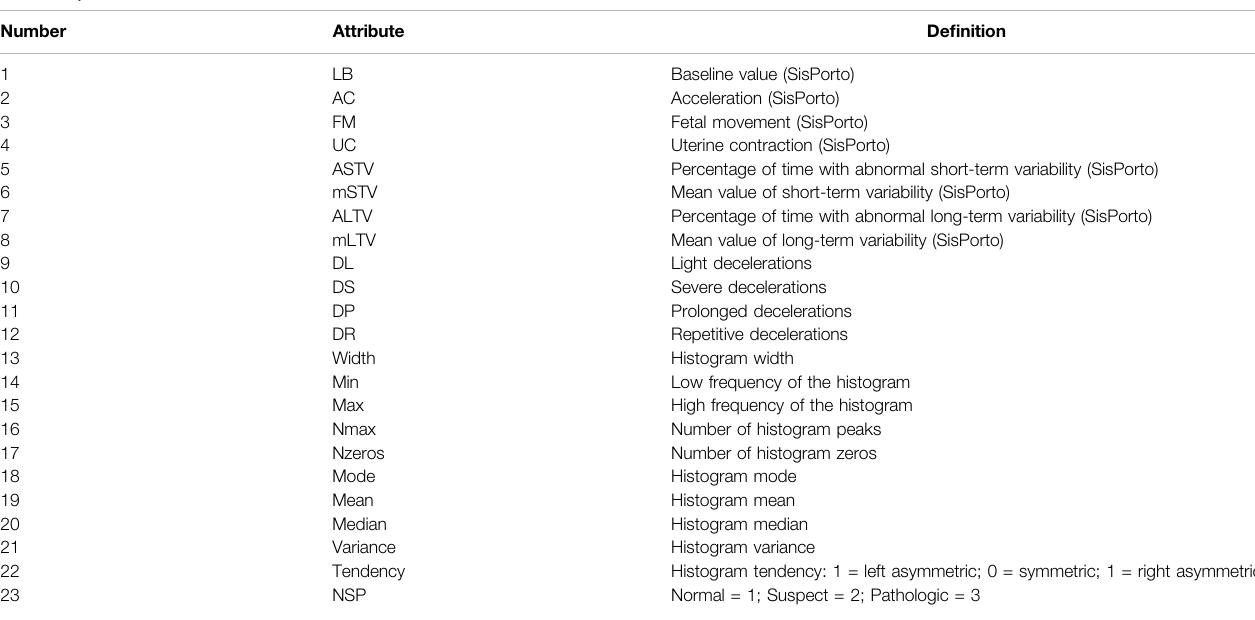
TABLE 1 | Attributes of the CTG